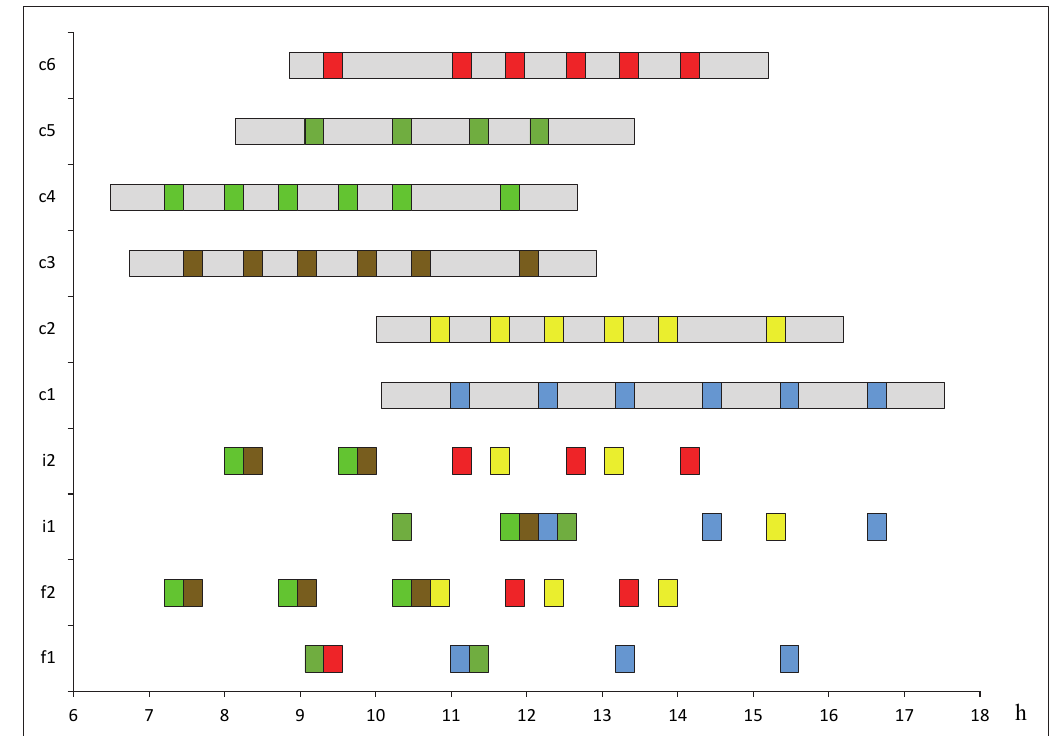
Fig. 3. Scheduling of the trucks arrivals given by the [H]